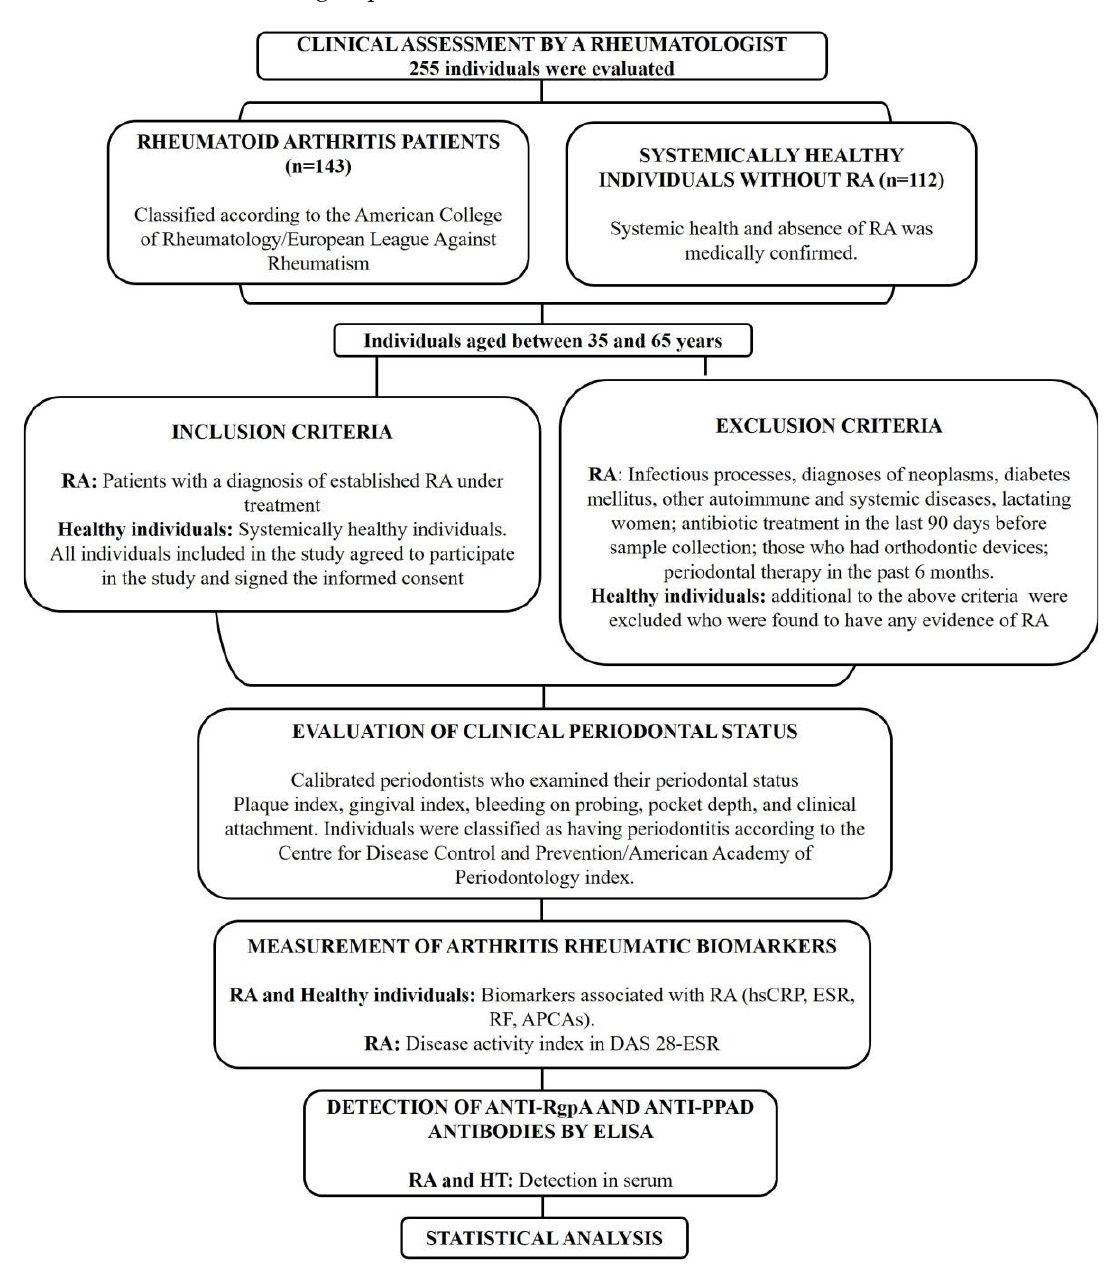
Figure 1. Flow chart of study population